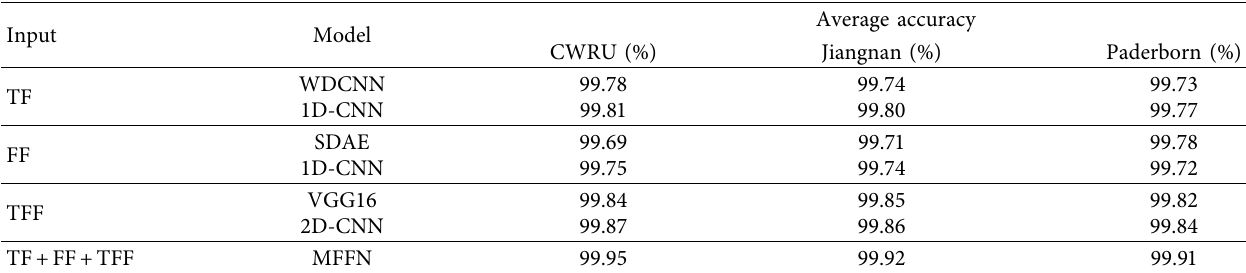
Table 5: The average performance in different